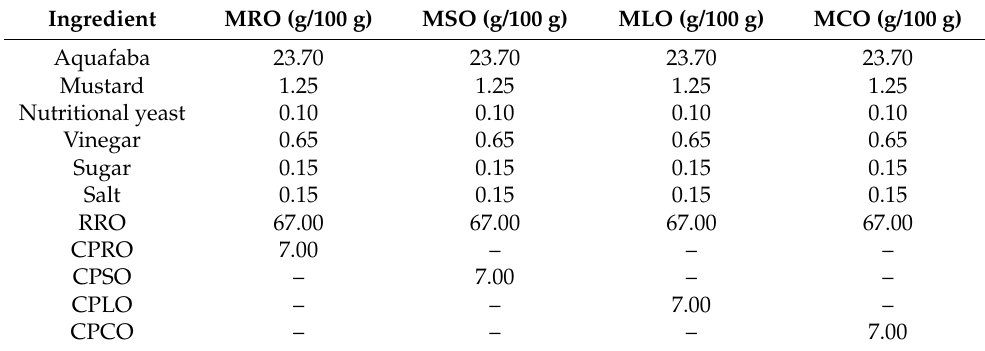
Table 1. Ingredients of different formulations of vegan mayonnaise samples.